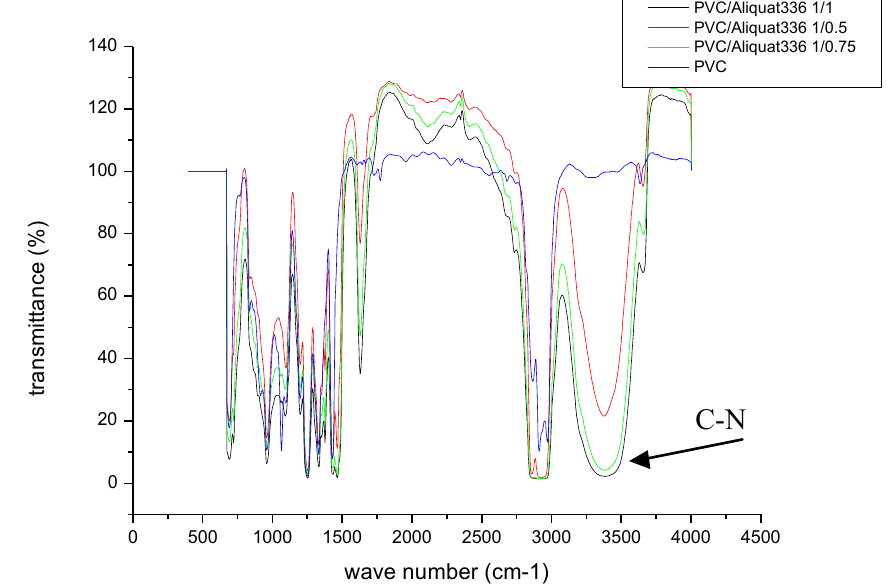
Figure 3. Infrared spectrum of the prepared membranes: PVC; PVC / Aliquat: 1 / 0.5; PVC / Aliquat: 1 / 0.75; and PVC / Aliquat: 1 / 1.